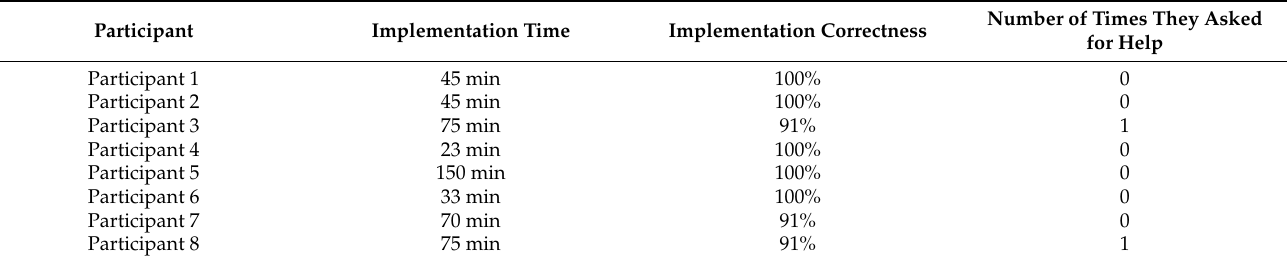
Table 3. The results of the evaluation for educational